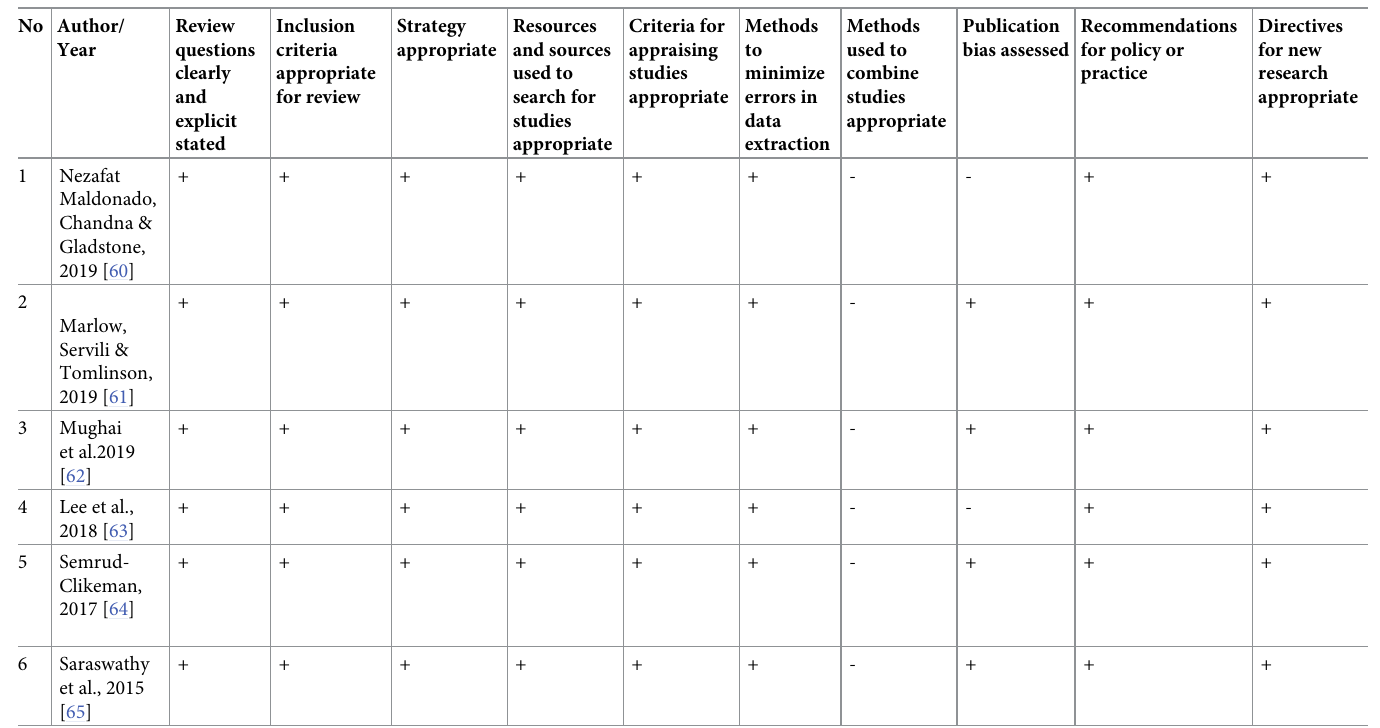
Table 2. A checklist for systematic review critical appraisal—Joanna Briggs Institute.